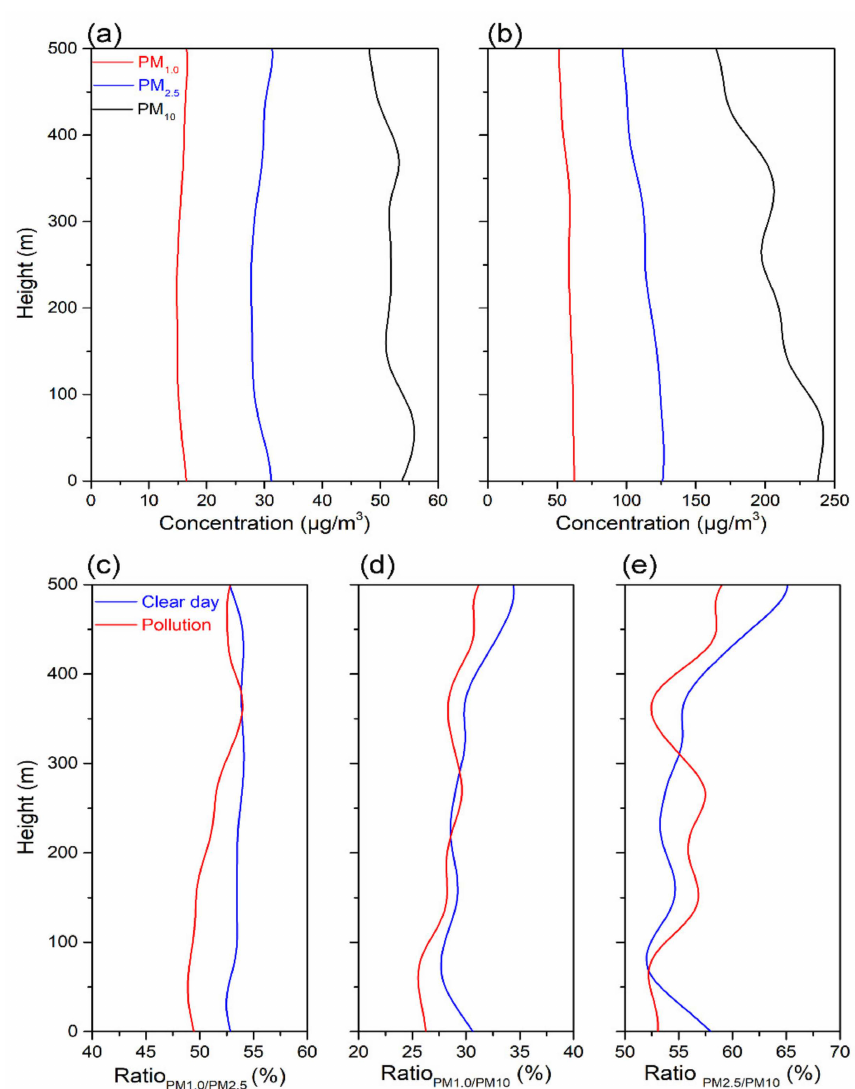
Figure 6. Comparison of the dust concentration between clear days ( a ) and pollution days ( b ); and the concentration ratio of ( c ) PM 1.0 /PM 2.5 , ( d ) PM 1.0 /PM 10 , ( e ) PM 2.5 /PM 10 in MF during the observation